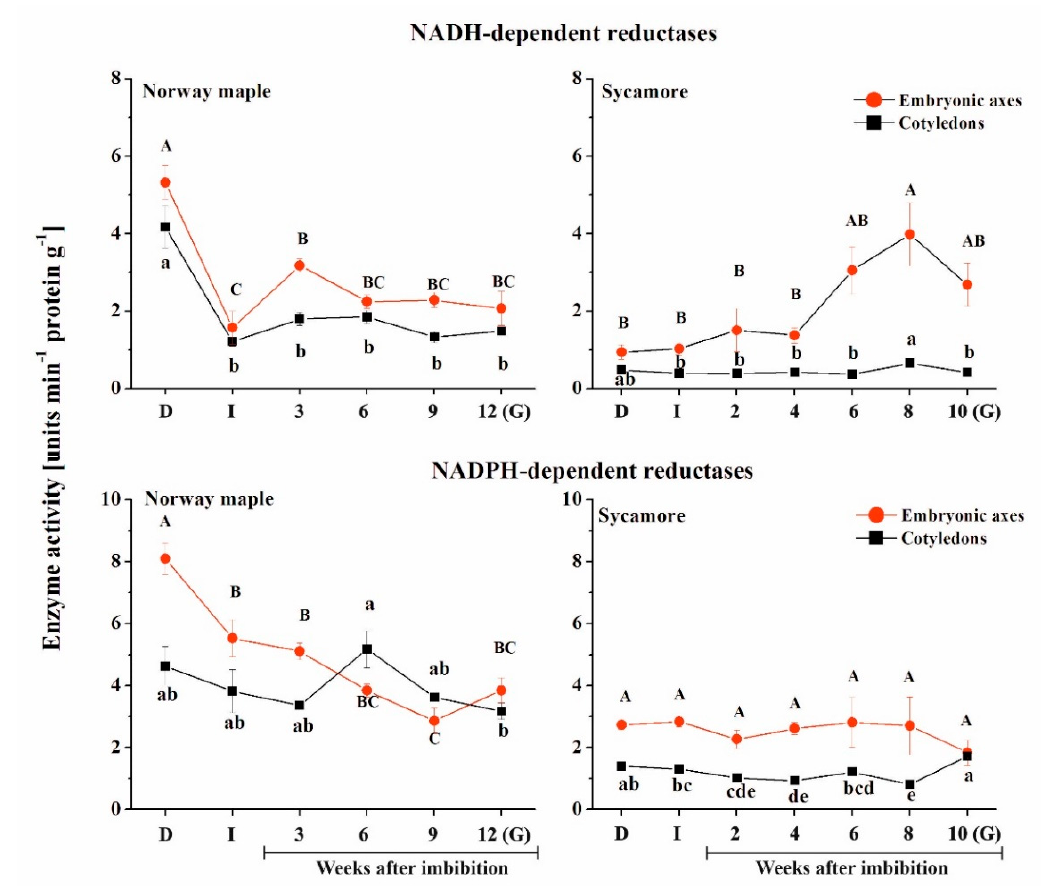
Figure 7. Activity of NAD(P)H-dependent reductases in the embryonic axes and cotyledons of Norway maple and sycamore dry and germinating seeds. Abbreviations: D, Dry seeds; I, Imbibed seeds; G, Germinated seeds. Statistically significant di ff erences are indicated with di ff erent letters (one-way ANOVA, followed by Tukey’s test at p ≤ 0.05).